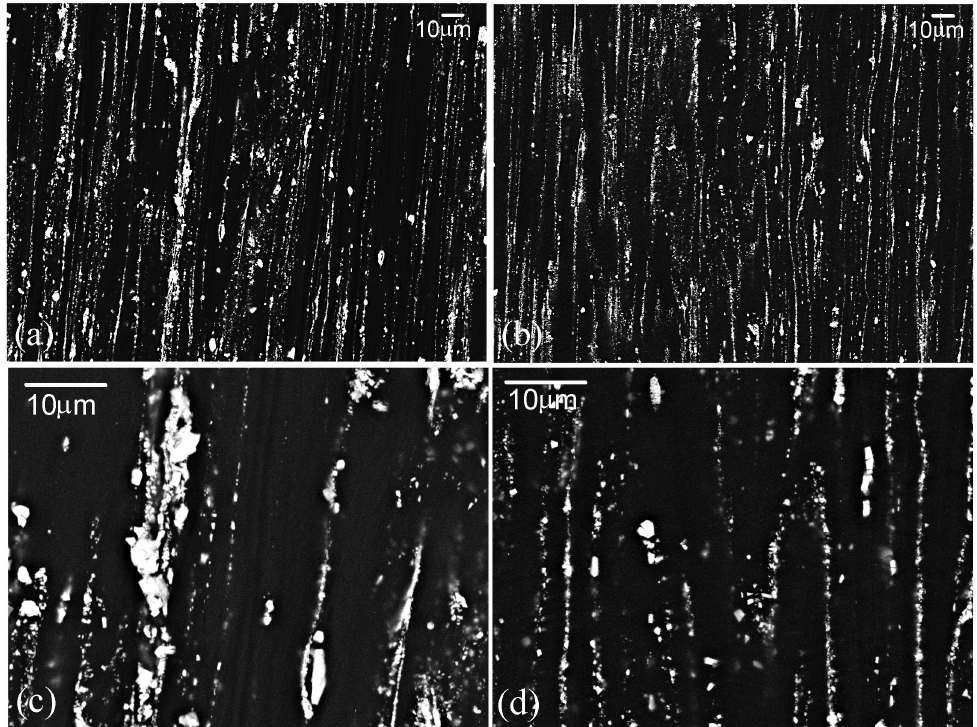
Figure 10. SEM images of ( a , c ) chill cast and ( b , d ) water-cooled cast alloy after extrusion. The extrusion direction is vertical in these micrographs. The relatively low magnification micrographs of ( a , b ) show the overall distribution of icosahedral phase particles, while the higher magnification micrographs of ( c , d ) show that locally the size and distribution of the particles is